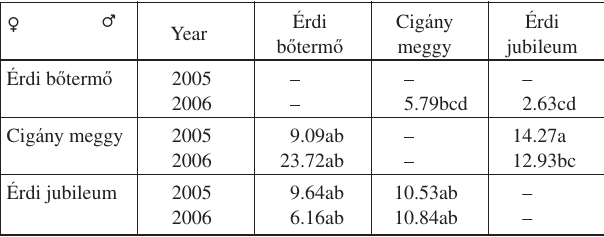
Table 3 . Final fruit set of cross pollination in sour cherry